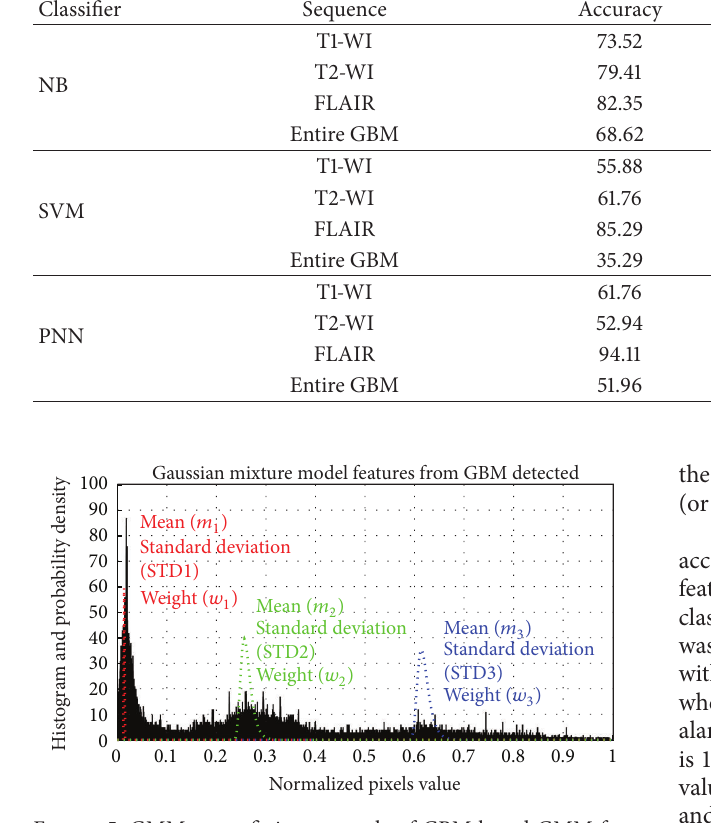
Figure 5: GMM curve fitting: example of GBM based GMM fea-